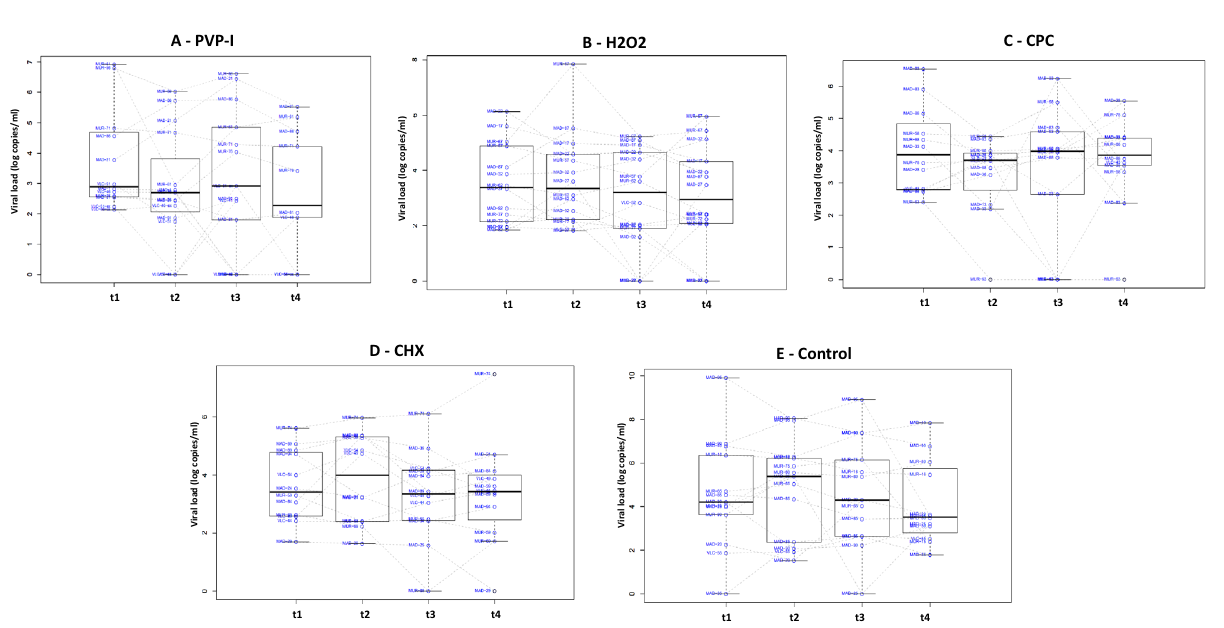
Figure 3. Salivary viral loads for all five treatment groups through time. Box plots show viral load levels, as measured by qPCR, for each of the patients in the group A—PVP-I (povidone-iodine), B—Hydrogen peroxide (H 2 O 2 ), C—CPC (cetylpyridinium chloride), D—CHX (chlorhexidine) and E—Distilled water (placebo group) at the four different timepoints (1 for basal and 2, 3 and 4 for the three times after the mouthwash, corresponding to 30, 60 and 120 min after the mouthwash, respectively). Lines joining the samples from the same patient are also